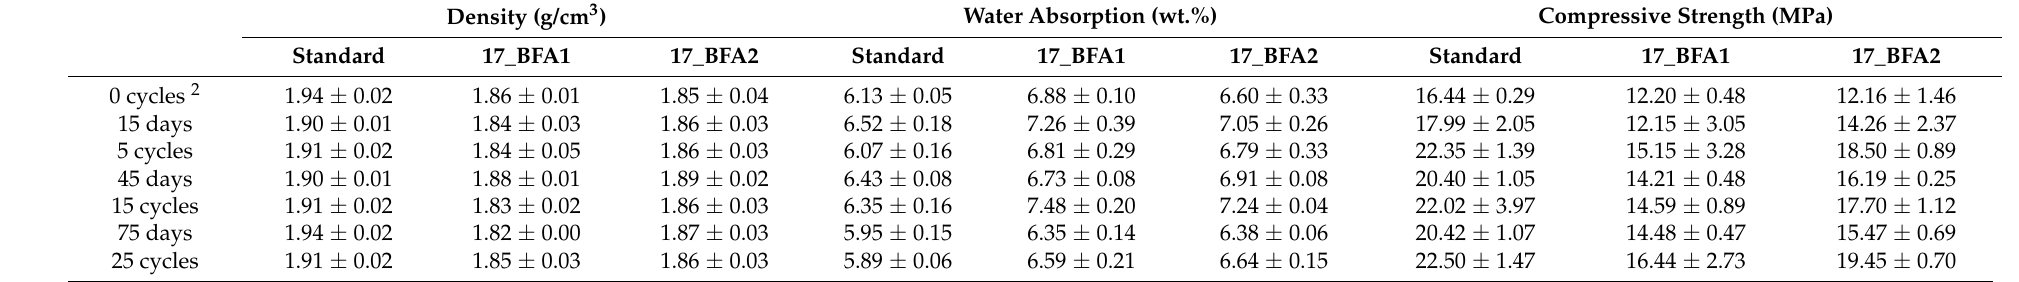
Table 3. Density, water absorption and compressive strength of samples subjected to 0, 5, 15, and 25 consecutive freeze–thaw cycles and of the control samples with the same